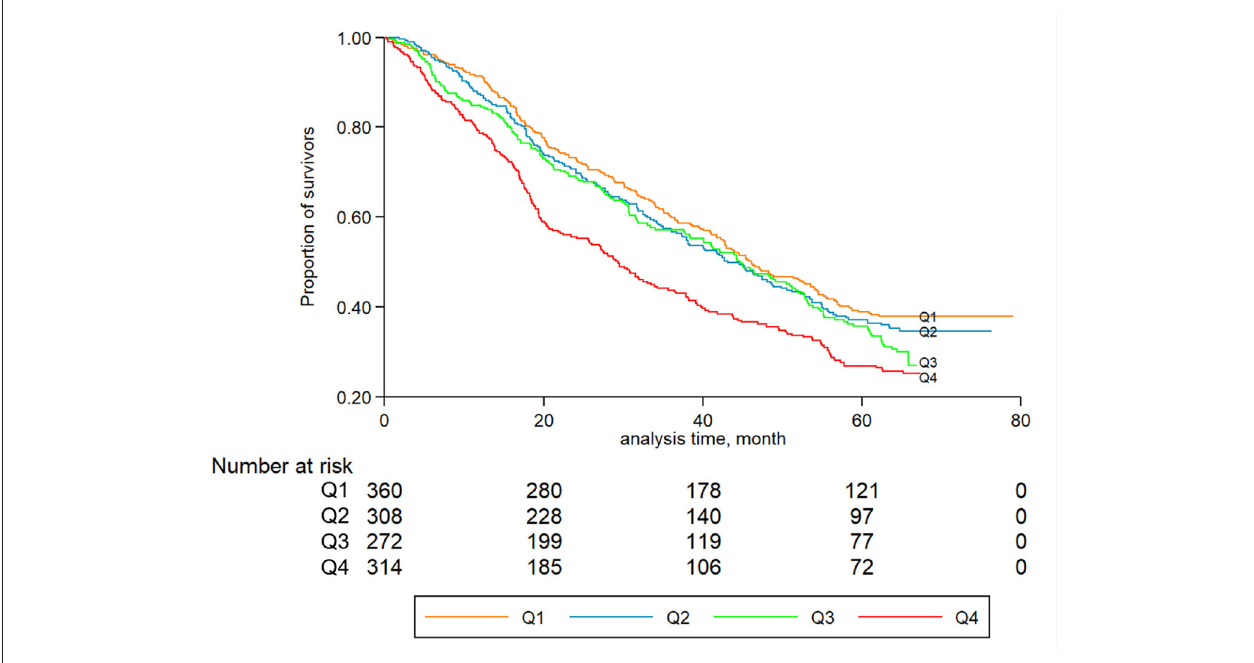
FIGURE 2 | Kaplan-Meier graphs for all-cause mortality by quartiles of CRP.